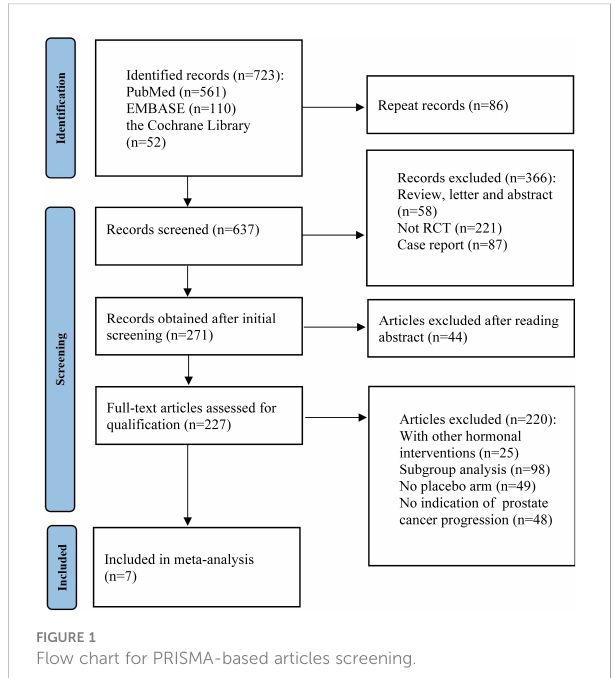
FIGURE 1 Flow chart for PRISMA-based articles